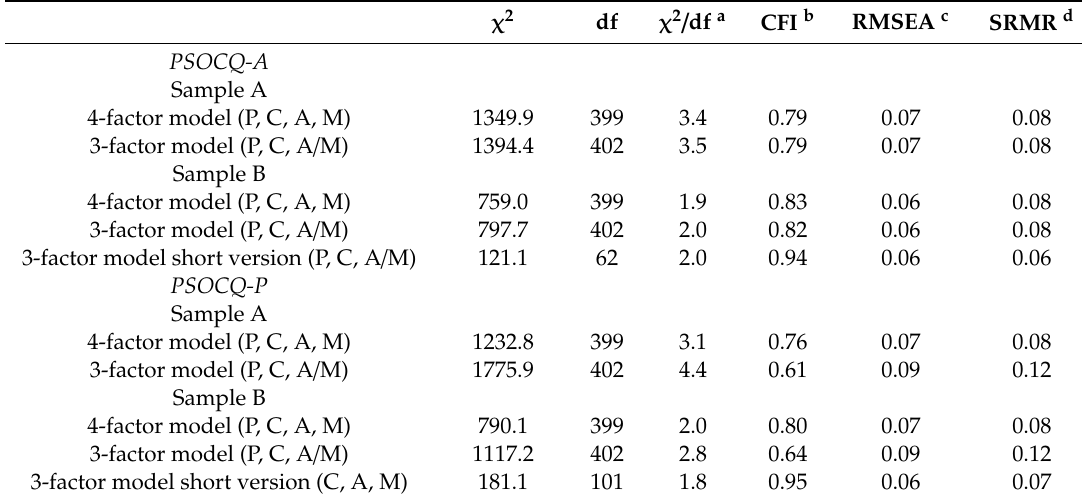
Table 2. Model fit indices of all models